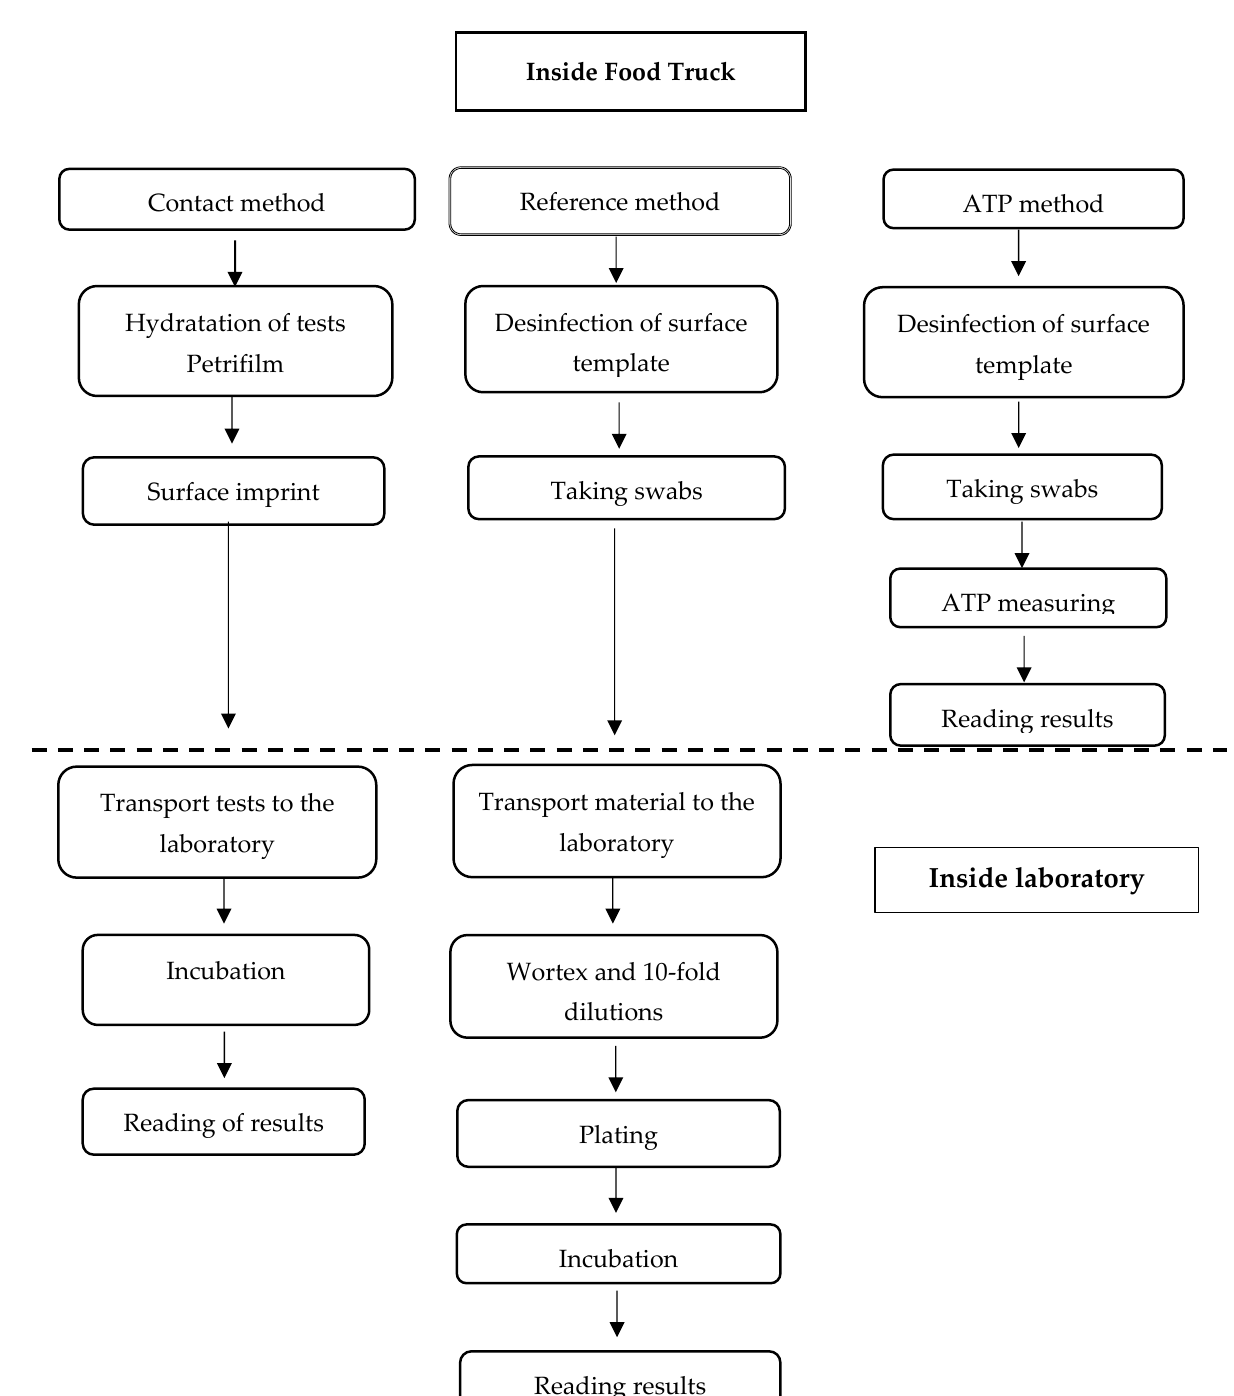
Figure 1. General scheme of analysis of hygiene state of food trucks.